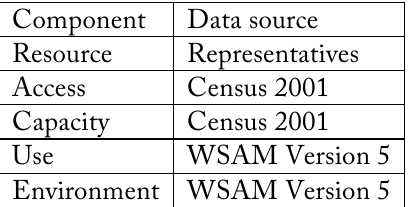
Table 1 WPI component data